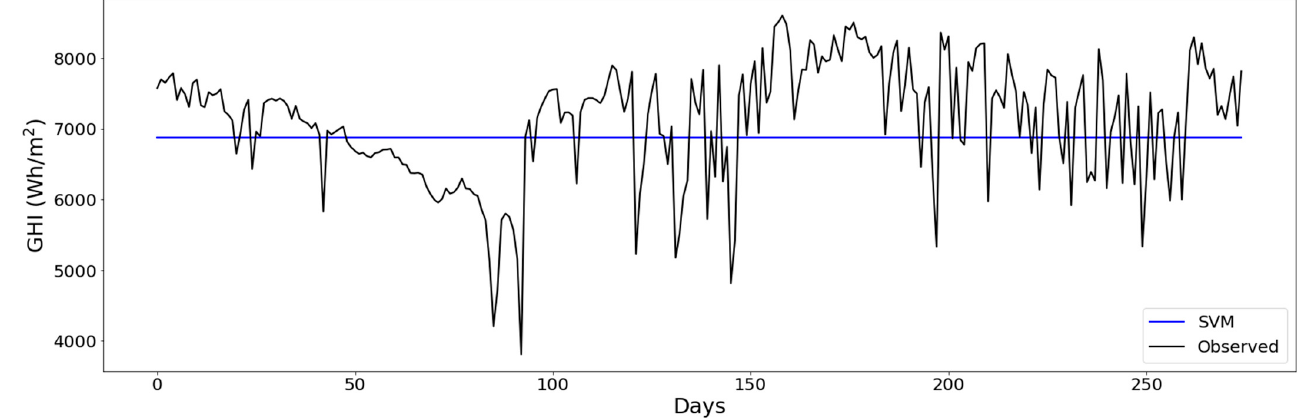
Figure 10. Logistic regression error frequency rate.